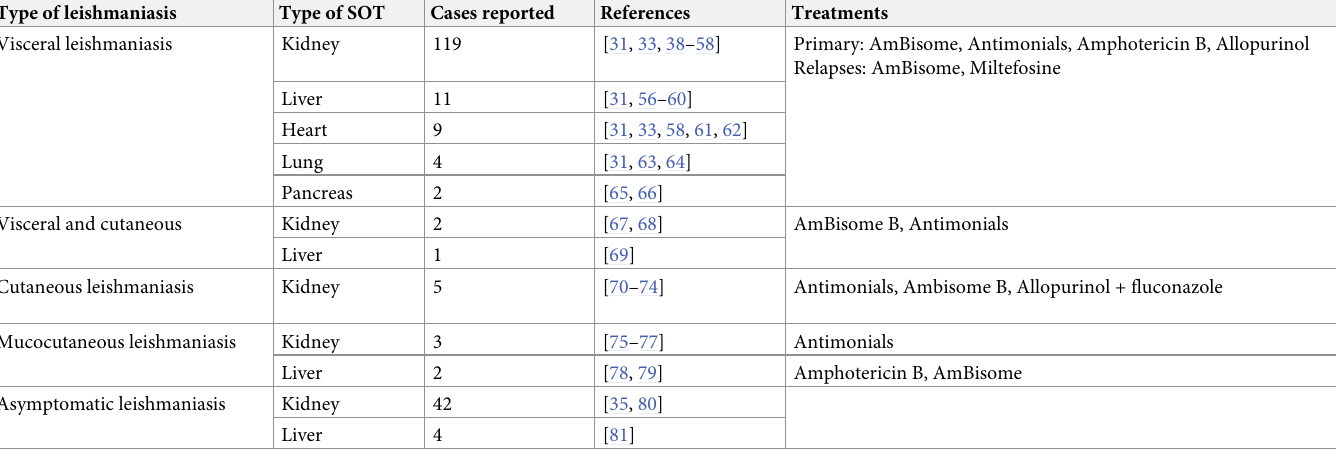
Table 4. Review of publications reporting cases of leishmaniasis in SOT recipients, describing the organ transplanted and the number of cases and the treatment options used for each type of leishmaniasis. Type of